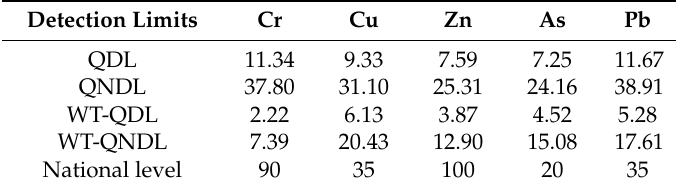
Table 4. Instrument detection limits ( n =